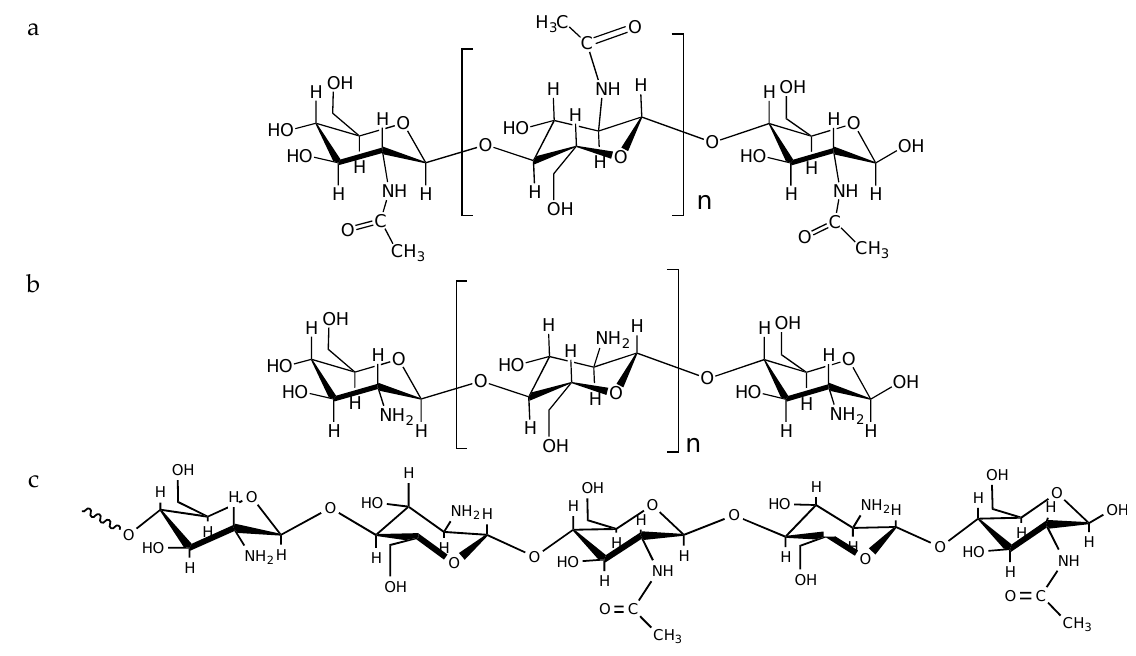
Figure 4. Structure of fully N-acetylated chitin ( a ), fully N-deacetylated chitosan ( b ) and representative partially N-acetylated chitosan sequence ( c ).